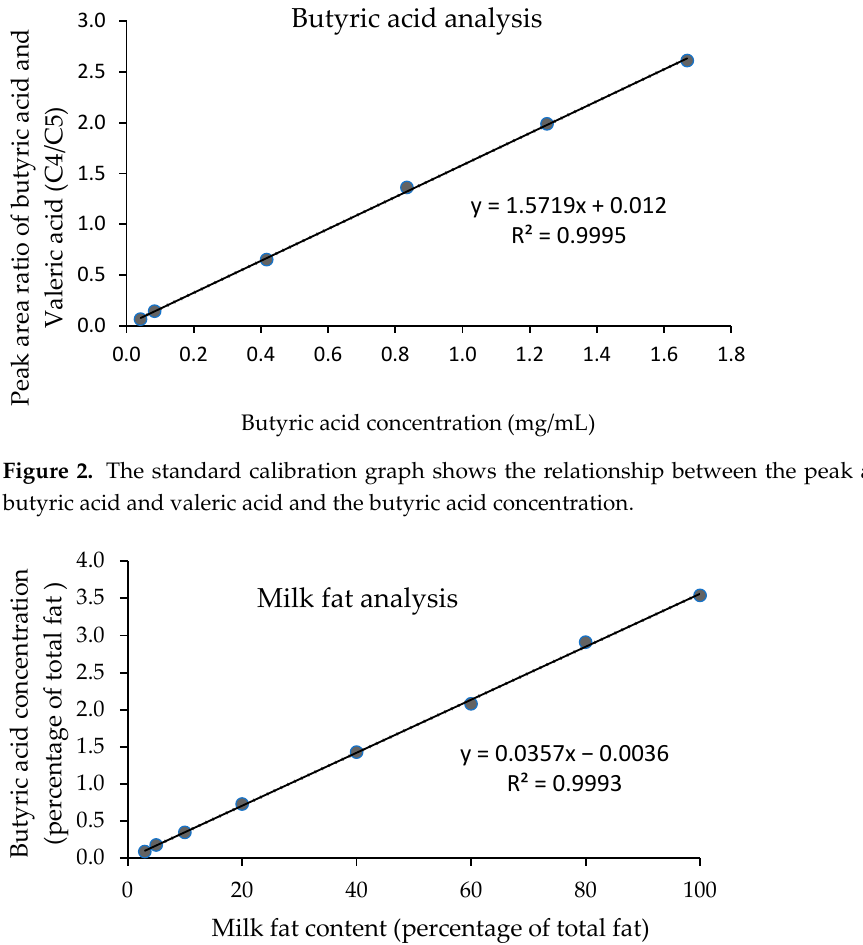
Figure 1. Chromatogram of butyric acid (C4) and valeric acid (C5) methyl esters in blended fat spreads analyzed by GC-FID.